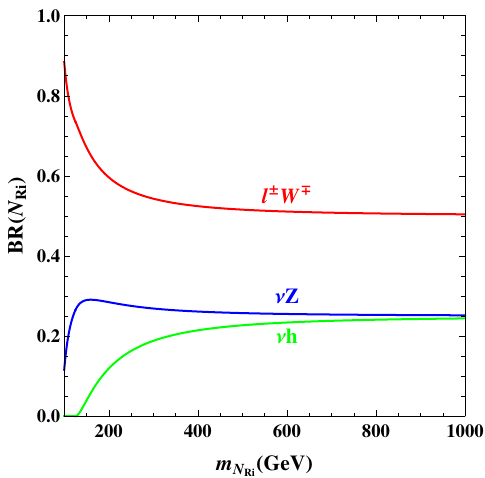
Figure 4 . Branching ratios of N Ri as a function of m N